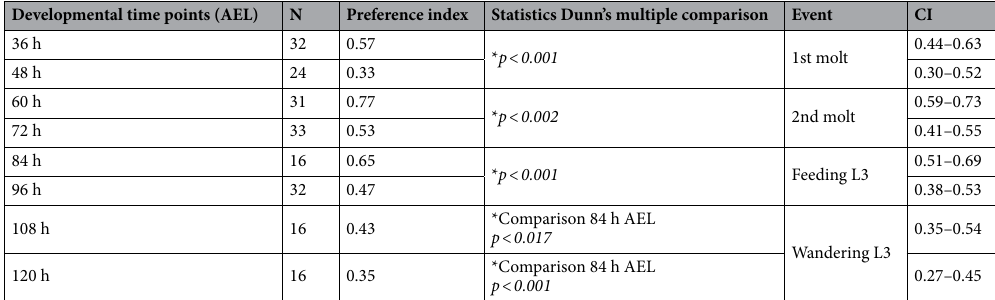
Table 1. Statistical analysis of substrate choice throughout the post-embryonal development of D. melanogaster